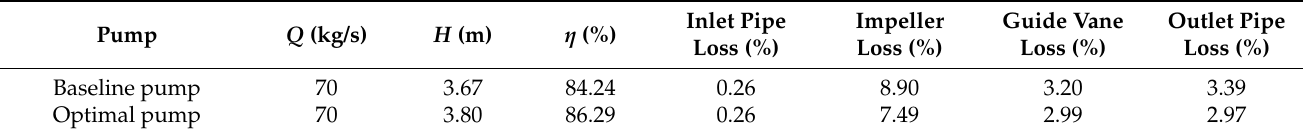
Table 8. Energy performance of baseline pump and optimal